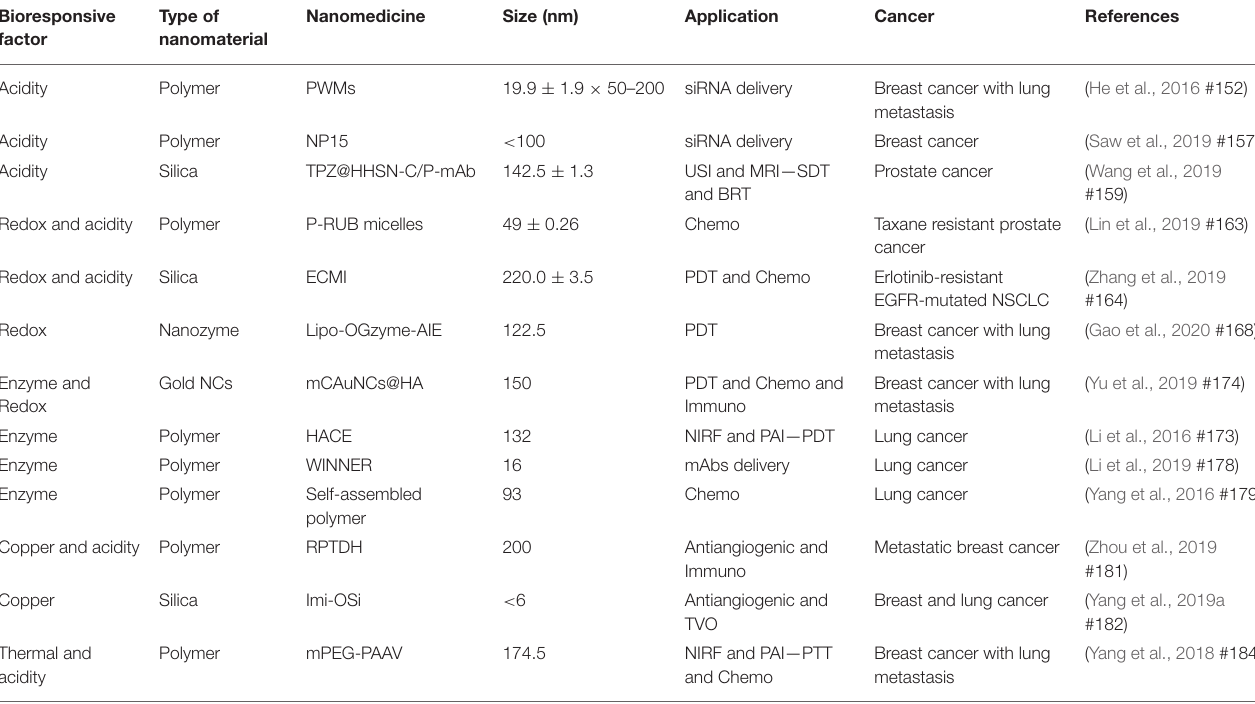
TABLE 1 | Recent advanced bioresponsive nanomedicine used in treating lung, breast, and prostate